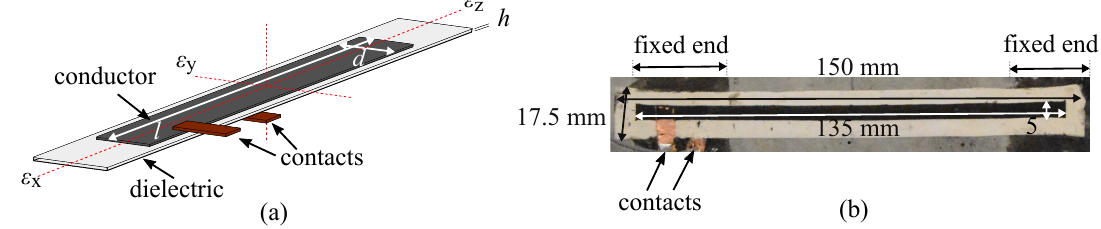
Figure 1. ( a ) Schematic representation of an SEC; ( b ) picture of an SEC with active sensing area measuring 135 mm × 5